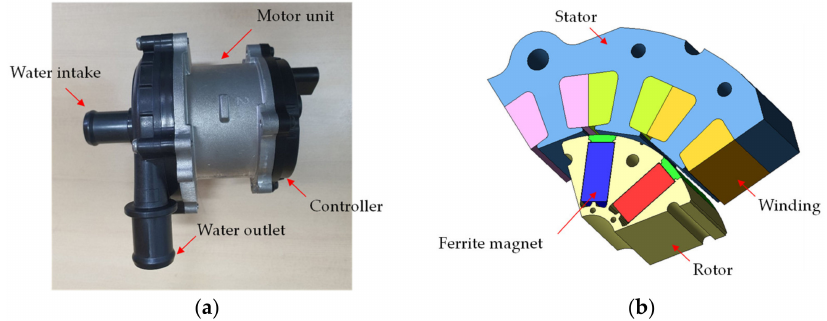
Figure 1. Electric water pump system: ( a ) configuration and major components; ( b ) basic motor unit.